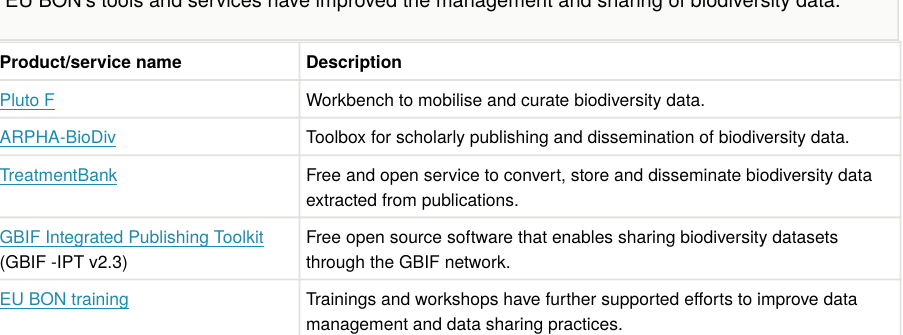
EU BON’s tools and services have improved the management and sharing of biodiversity